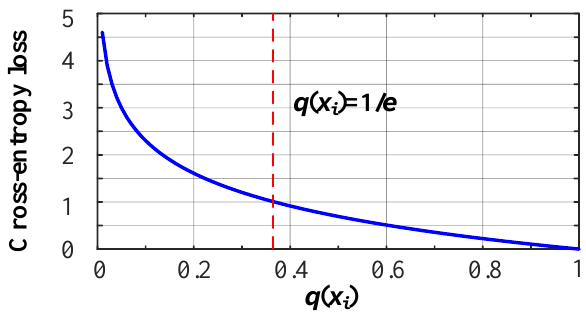
Figure 2. Simplified cross-entropy